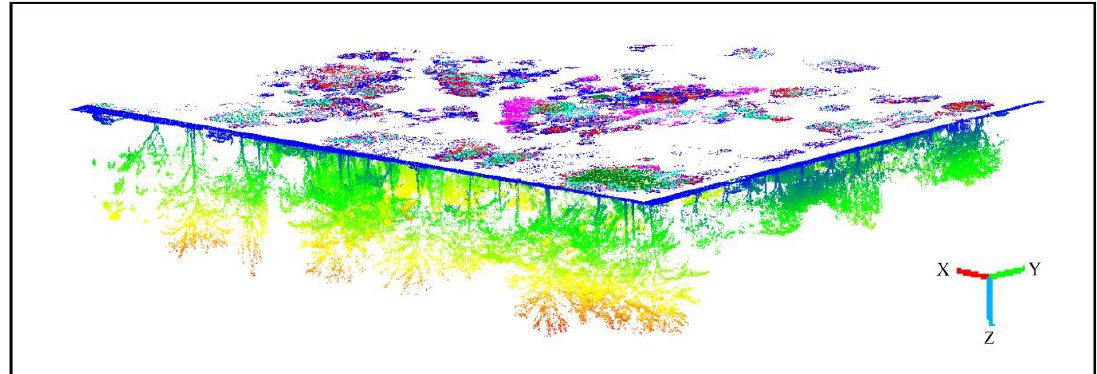
Figure 6. (Top): Multispectral classification data; (Bottom) Point-cloud data. Calculation of Individual Tree Biomass of Classified Tree